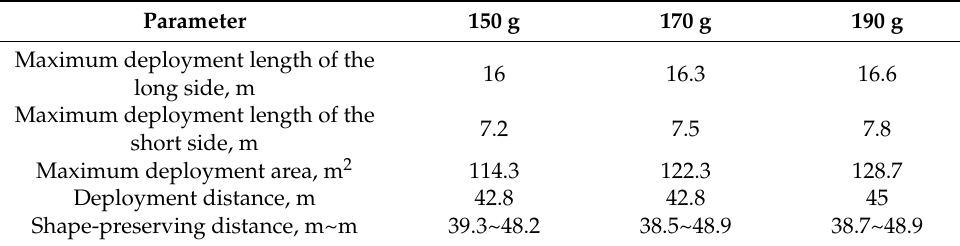
Figure 17. Deployment performance with different towing block mass values. ( a ) Launch distance. ( b ) Deployment length of long side. ( c ) Deployment length of short side. ( d ) Deployment area. Table 4. Deployment parameters with different towing block mass.